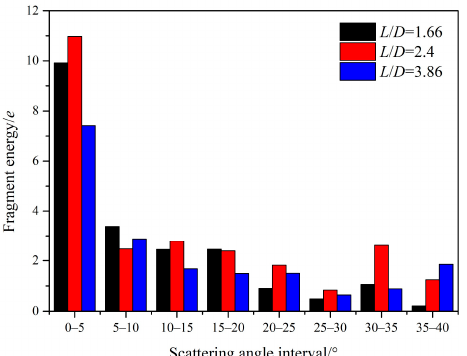
Figure 13. Average energy distribution of BAD in different scattering angle ranges.